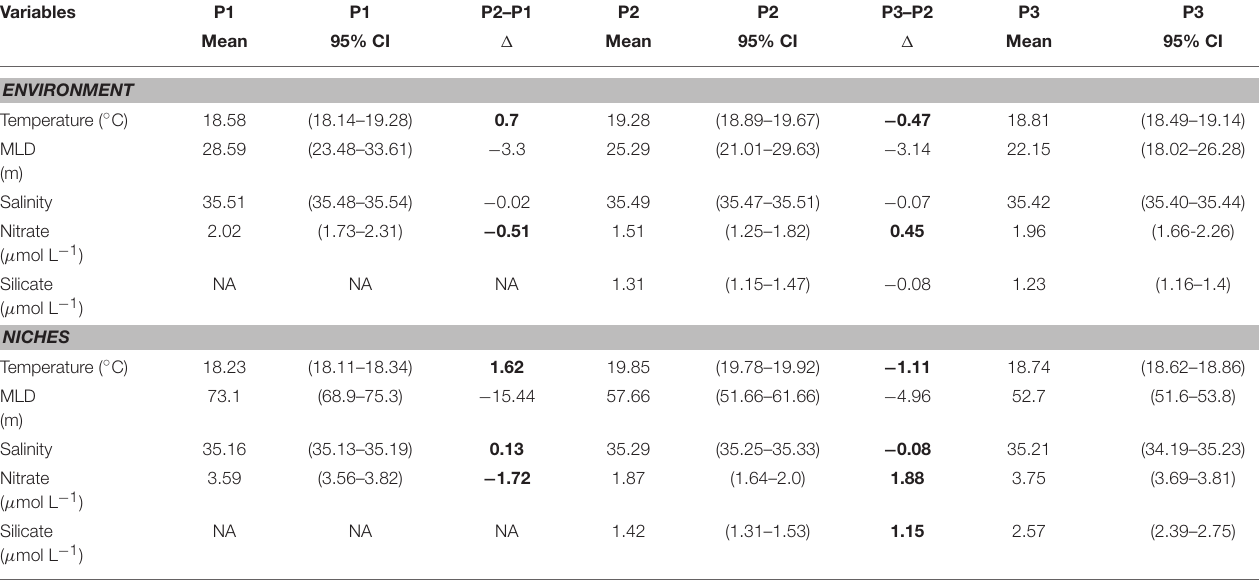
TABLE 2 | Mean environmental conditions (top) and niches (bottom), 95% confidence interval on the mean, and change in means between two periods for temperature, mixed layer depth (MLD), salinity, nitrate and silicate concentrations over time (P1: 1965–1979, P2: 1997–2004, and P3: 2005–2009) at the Port Hacking monitoring